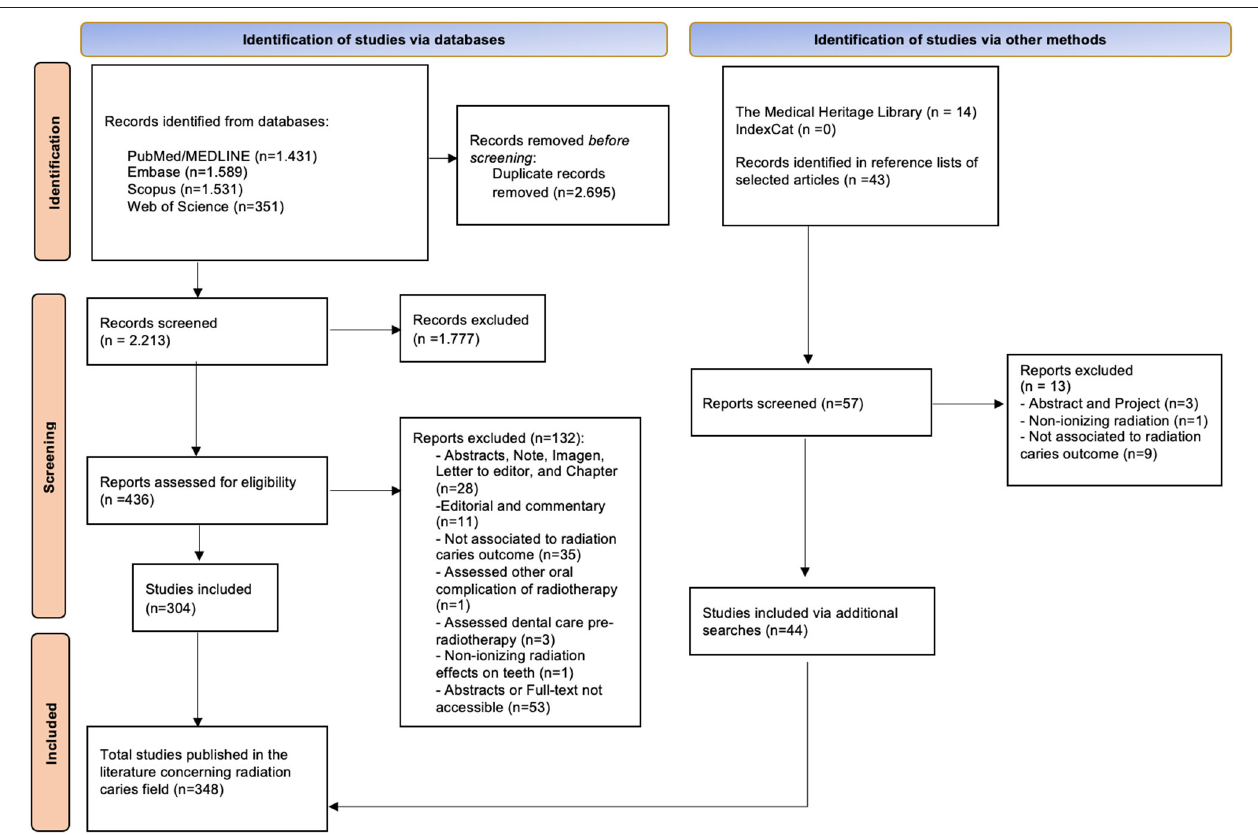
FIGURE 1 | Flowchart describing literature